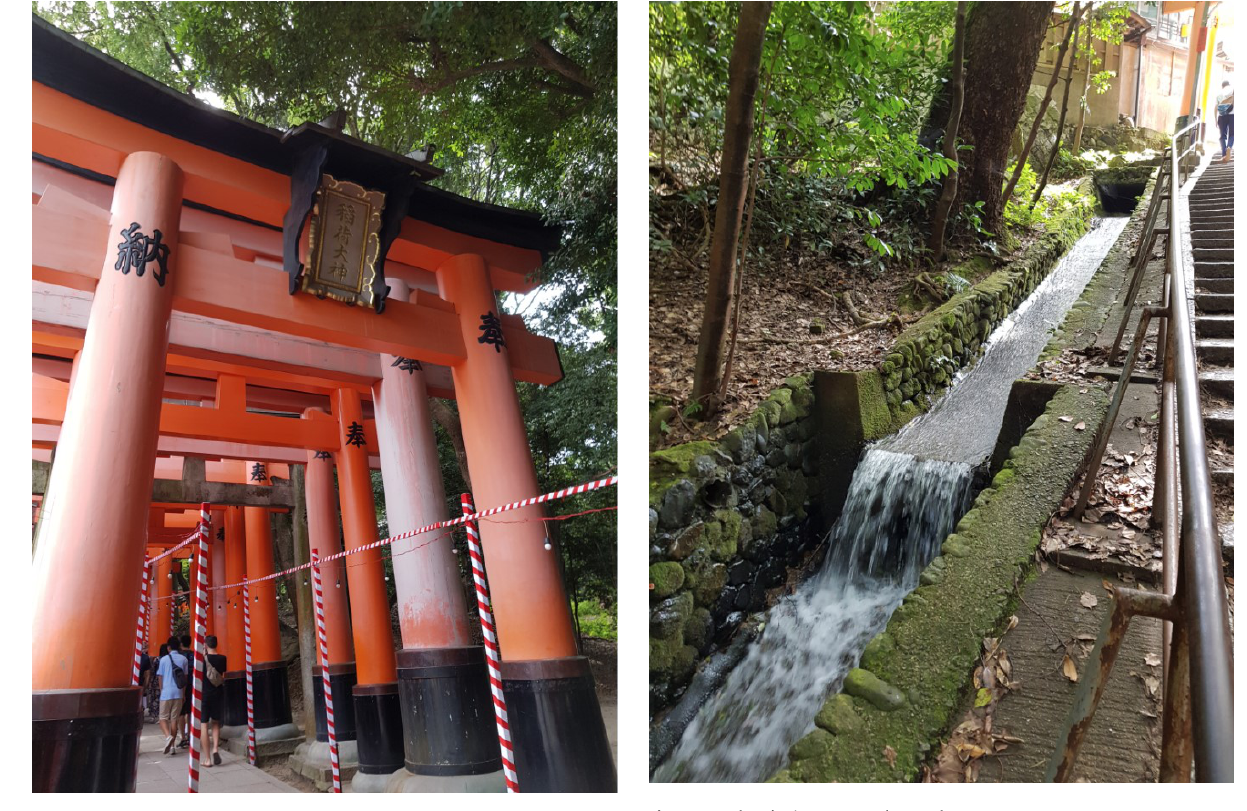
Figure 7: The starting point of the torii gates Figure 8: